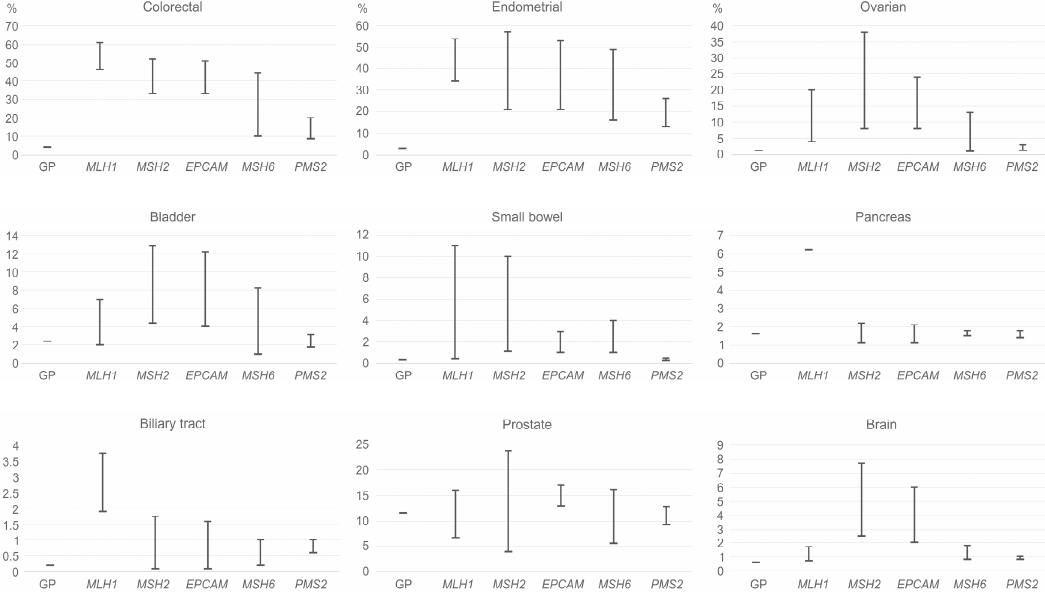
Figure 1. Lynch syndrome-associated cancer risks by age 80, according to the NCCN guidelines. GP = general population.